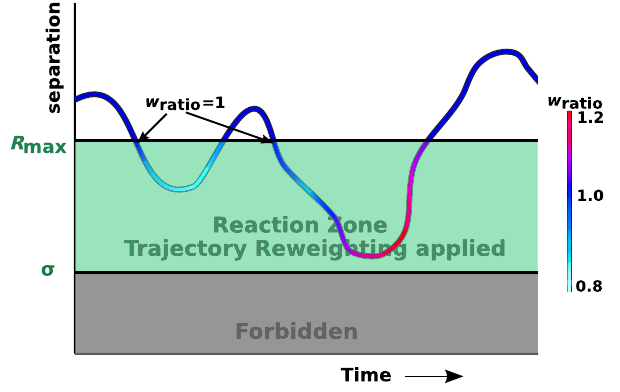
FIG. 3. Illustration of a trajectory tracking the separation between a pair of particles versus time. The particles cannot come closer together than the binding radius σ , and when they are separated by less than R , they have a nonzero probability of max associating during the next time step, which increases the closer they get. Within the reaction zone, the probabilities of sampling this trajectory using the free-diffusion propagator and the exact RD propagator differ. Therefore, in this region, the association probability is reweighted by the ratio of trajectory probabilities to recover the correct association rate that would be achieved by using the exact propagator. The color scale indicates a possible example of how the reweighting ratio would evolve within the reaction zone. When the trajectory exits the reaction zone, its value of w will, in general, not be one, but because the average ratio over all trajectories is one, and memory of the near encounter is lost, we can reinitialize w to one upon reentering the ratio reaction